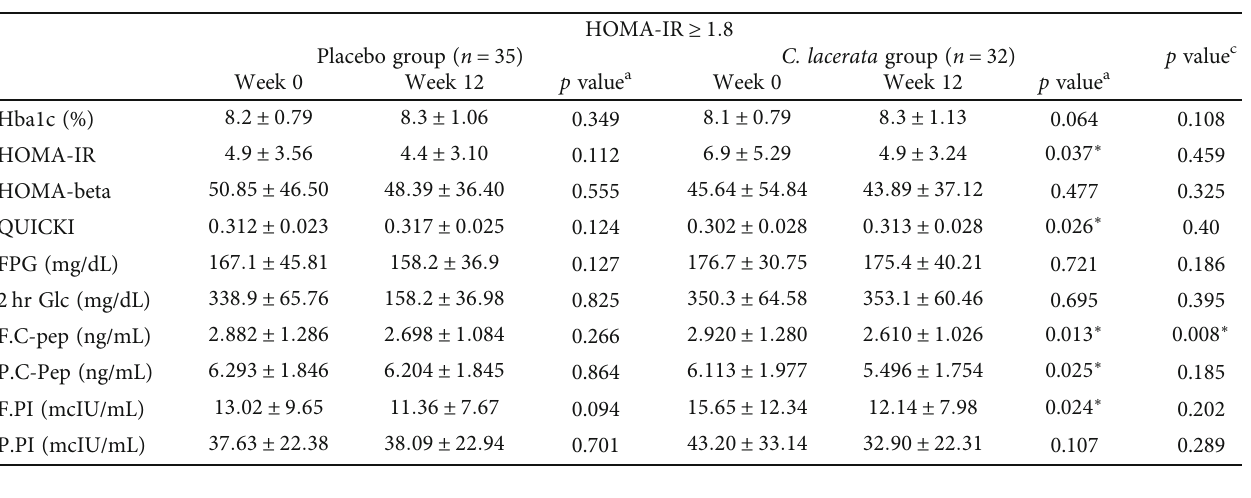
(a) HOMA ‐ IR ≥ 1 : 8 C. lacerata group ( n = 32 )